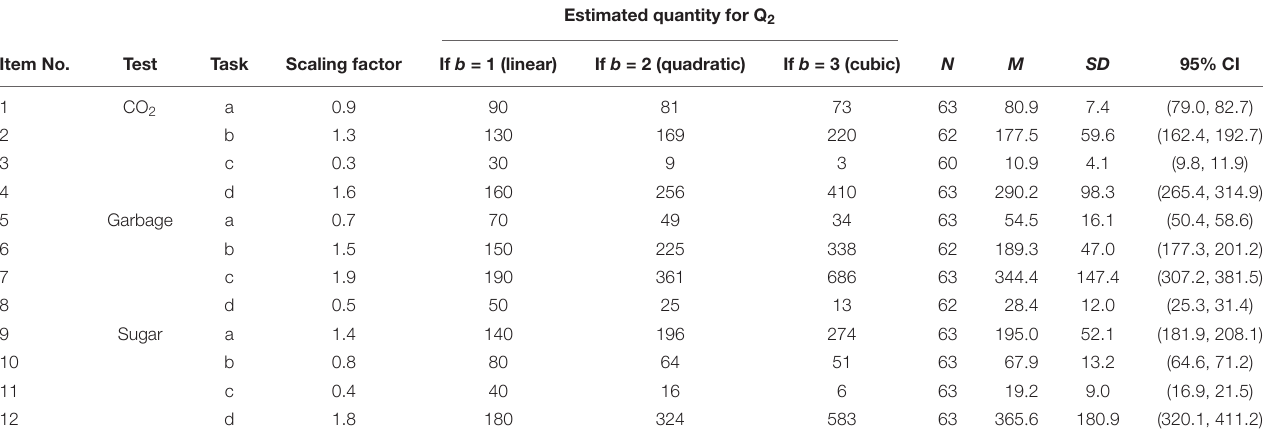
TABLE 1 | Descriptive information concerning the